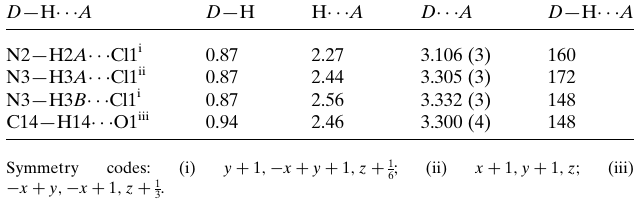
Table 2 Experimental